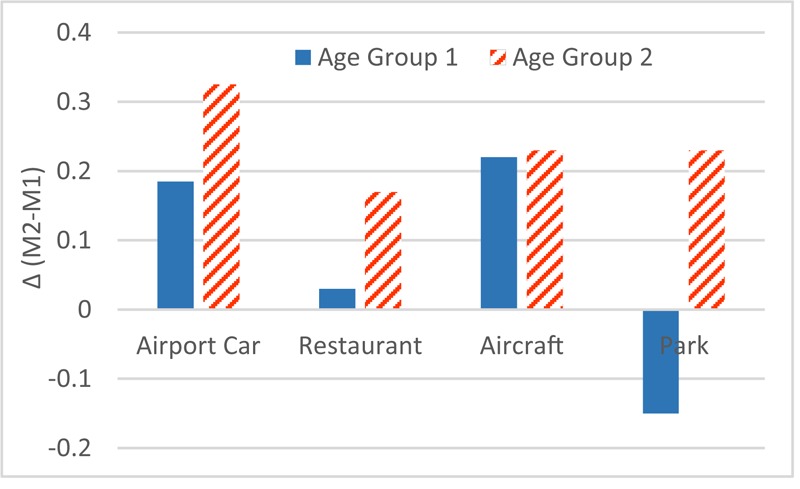
Disparity of M1 and M2 by age groups.